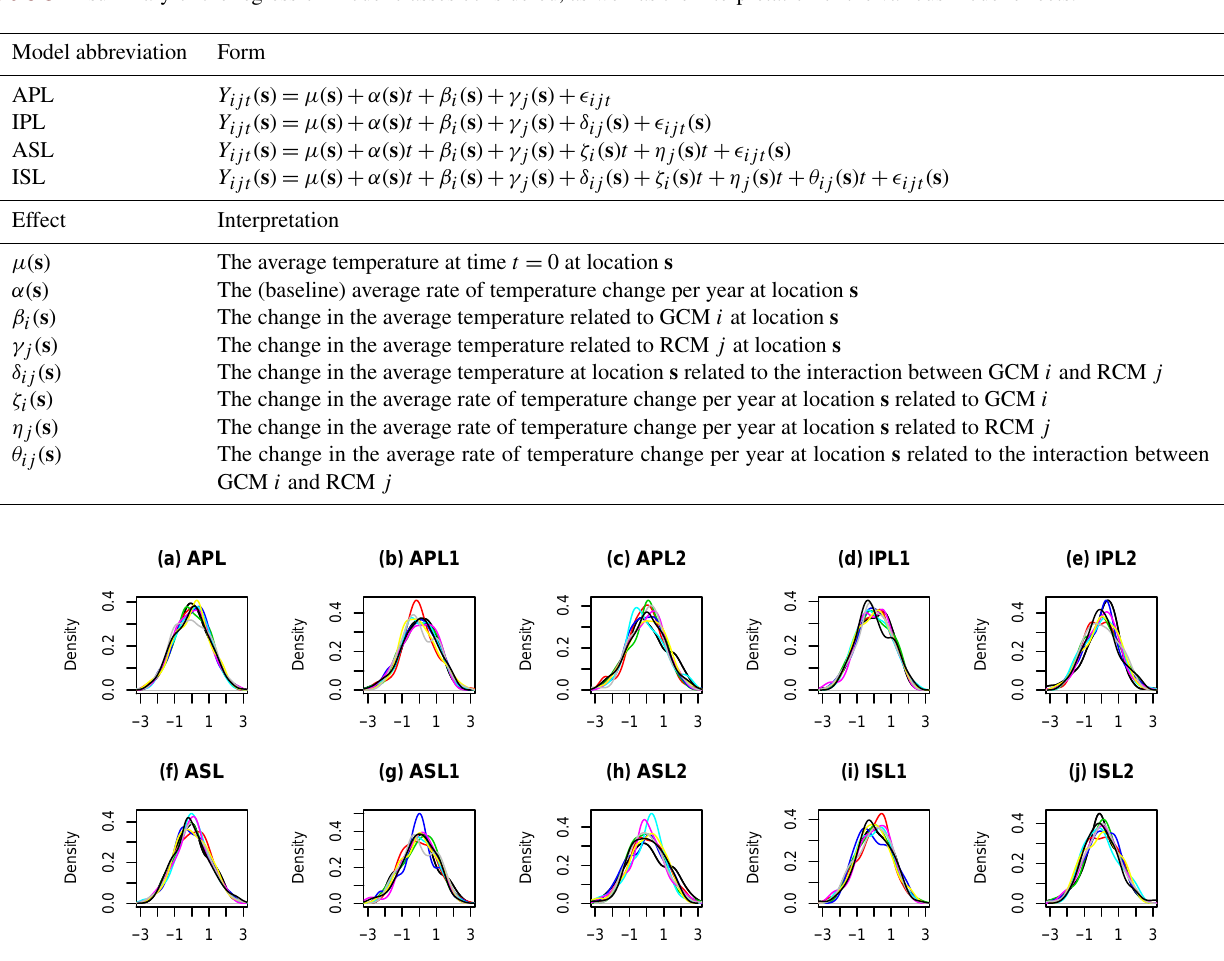
Figure 3. Plots of estimated densities for the transformed residuals from randomly selected locations from each fitted model. The title above each plot indicates the model from which the residuals were taken, with the “1” or “2” indicating the data were fitted to mini-experiments 1 or 2, respectively. This figure demonstrates the near-Gaussian character of the transformed residuals, implying the estimated regression coefficients are approximately Gaussian, as required by Assumption